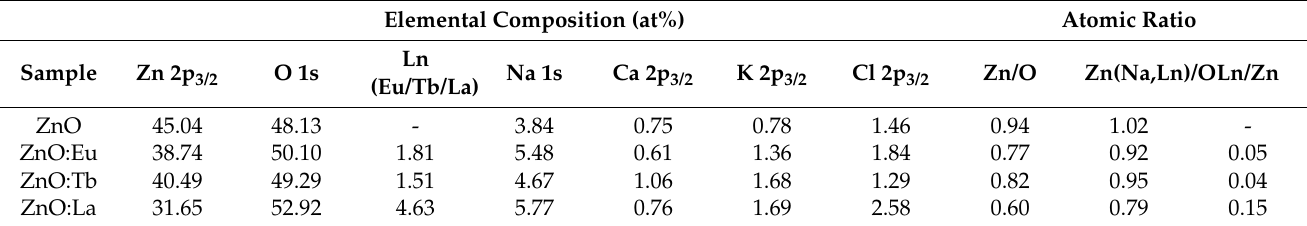
Figure 4. XPS spectra of Eu-, Tb-, and La-doped ZnO; and undoped ZnO. Table 2. Elemental composition of ZnO, ZnO:Eu, ZnO:Tb and ZnO:La samples. Table 2. Elemental composition of ZnO, ZnO:Eu, ZnO:Tb and ZnO:La samples. Elemental Composition (at%) Atomic Ratio Elemental Composition (at%) Atomic Ratio